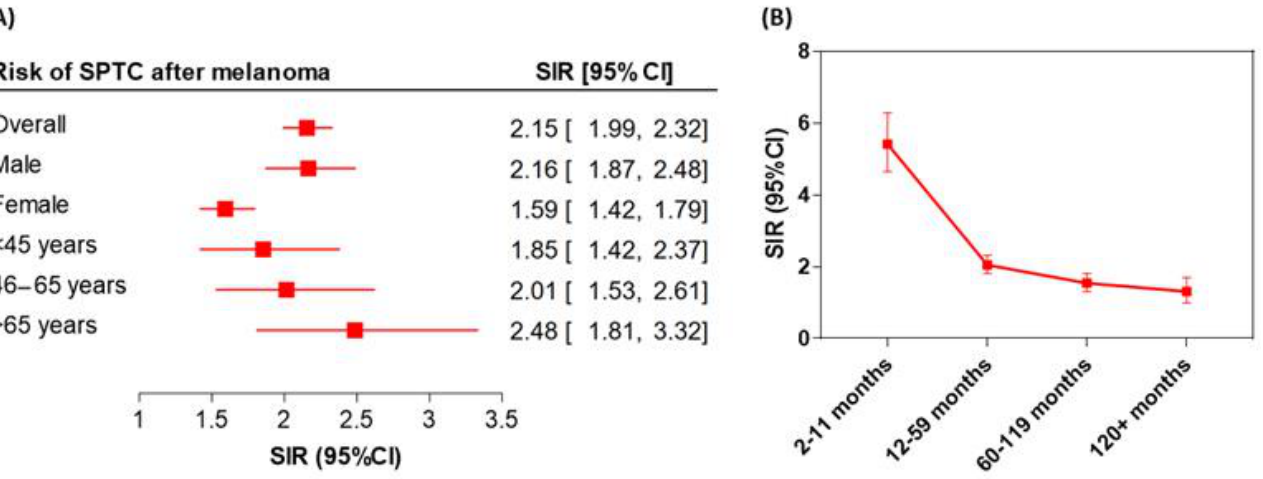
Figure 1. Risk of second primary thyroid cancer (SPTC) following malignant melanoma. ( A ) Standardized Incidence Ratio (SIR) stratified according to the gender and age groups. ( B ) Latency course of risk of SPTC within the first 10 years of follow-up of melanoma patients. The error bars indicate the 95%CI.